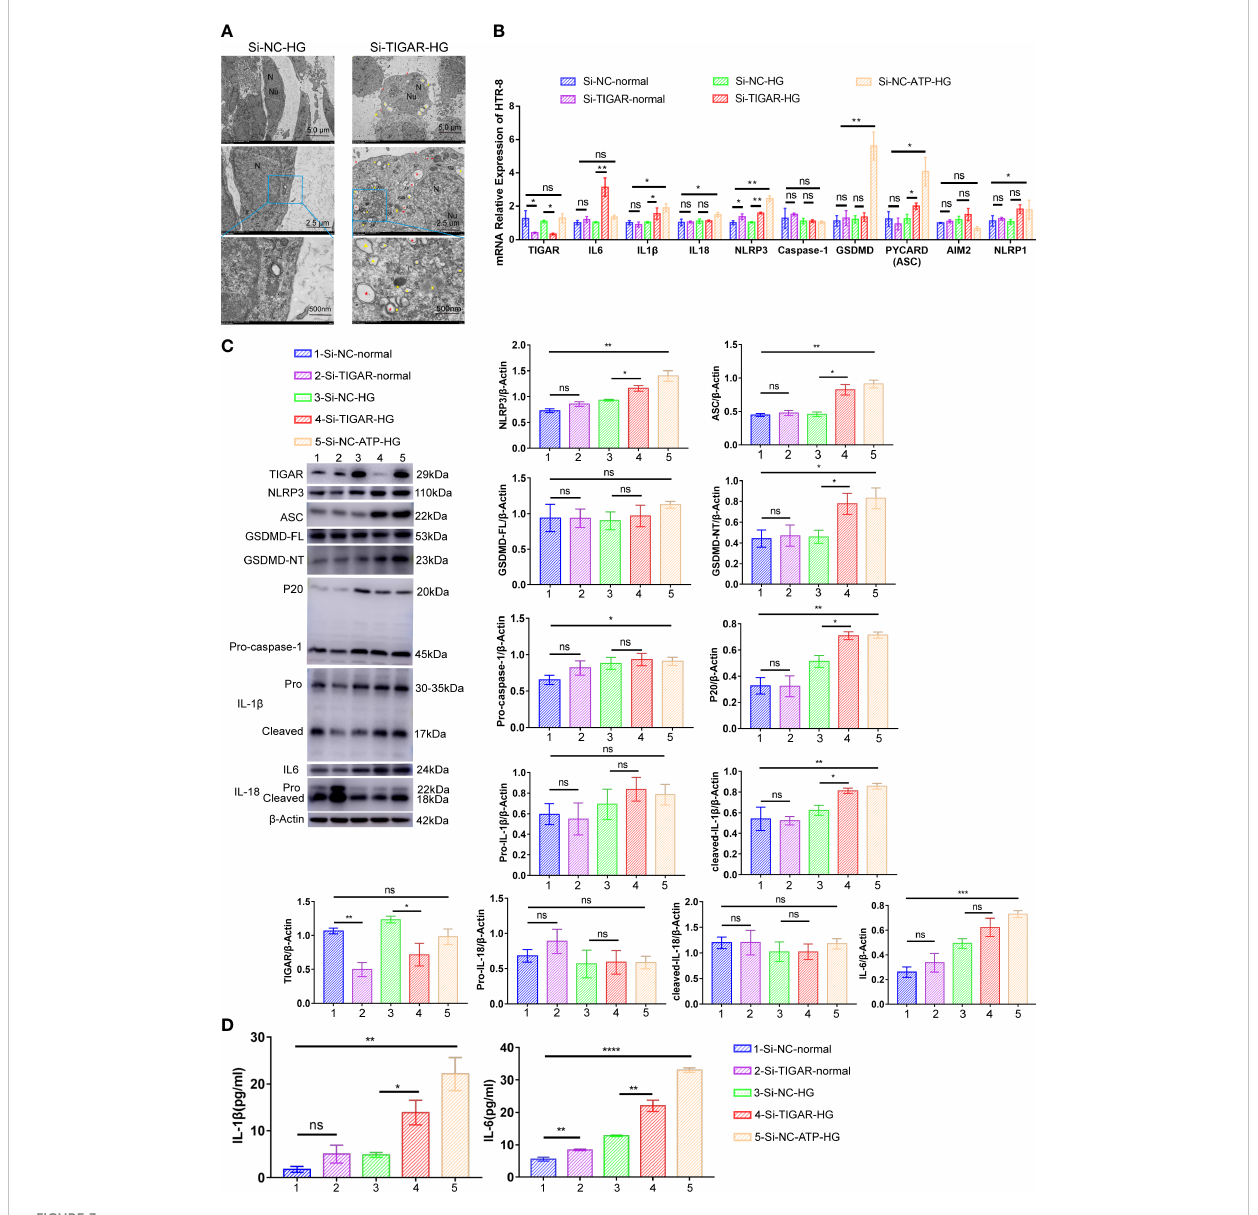
FIGURE 3 TIGAR de fi ciency induced pyroptosis in HTR-8 upon HG treatment. (A) Representative transmission electron microscopy (TEM) images of HTR-8 cells when cultured in normal or HG condition, which was transfected with Si-TIGAR or Si-NC. Red arrowheads, membrane pores and disrupted regions; Yellow arrowheads, large bubbles; Red arrow, overt mitochondria swelling; Red asterisks*, double-membrane autophagosomes (AP); Yellow asterisks *, autolysosomes (ASS). Expression of NLRP3, ASC, GSDMD-FL, GSDMD-NT, Pro-caspase-1, P20, Pro-IL-1 b , cleaved-IL-1b, and IL-6 in HTR-8 cells, as detected on RNA (B) and protein levels (C) . The expression of these proteins is quanti fi ed by normalizing to b -actin (n=3) . (D) ELISA for IL-1 b and IL-6 release of HTR-8 cells treated with normal/HG in the presence or absence of TIGAR knockdown. Data of the triple experiments are presented as the means ± SEM. *p < 0.05, **p < 0.01, ***p < 0.001, ****p < 0.0001 versus the indicated group, ns, no signi fi